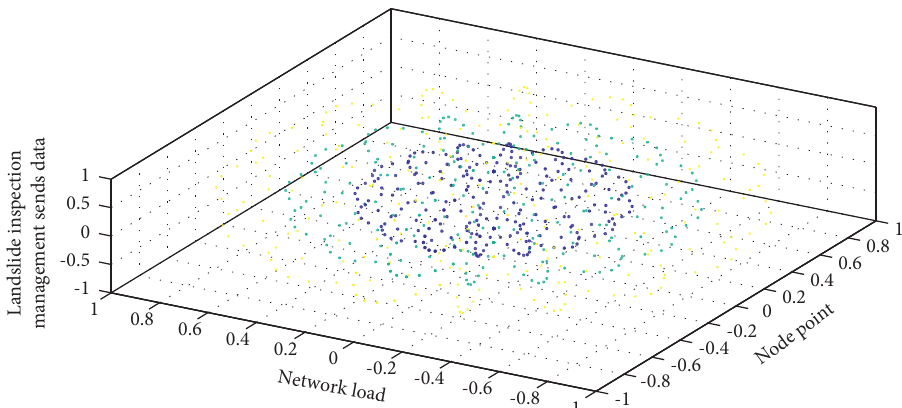
Figure 3: Distribution of data sent by landslide inspection management.